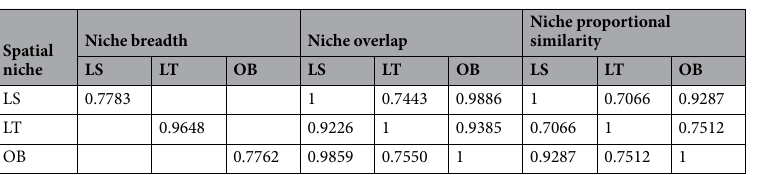
Table 2. Spatial niche of the two leafminer species, Liriomyza sativae (LS) and L. trifolii (LT) and the pupal parasitoid, Opius biroi (OB).